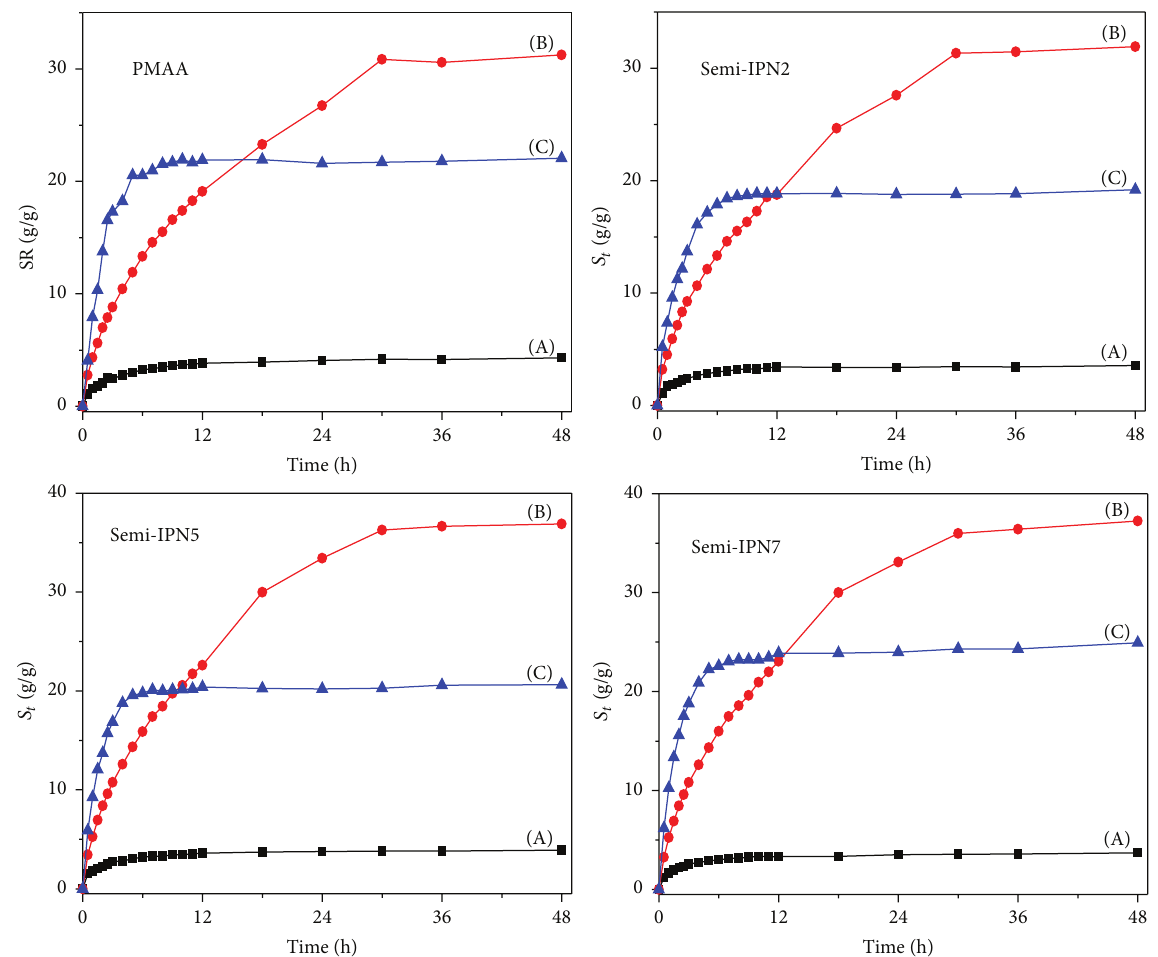
Figure 7: Time-dependent swelling ratio of the hydrogels in buffer solutions of pH 2.0 (A), 7.4 (B), and 10 (C).